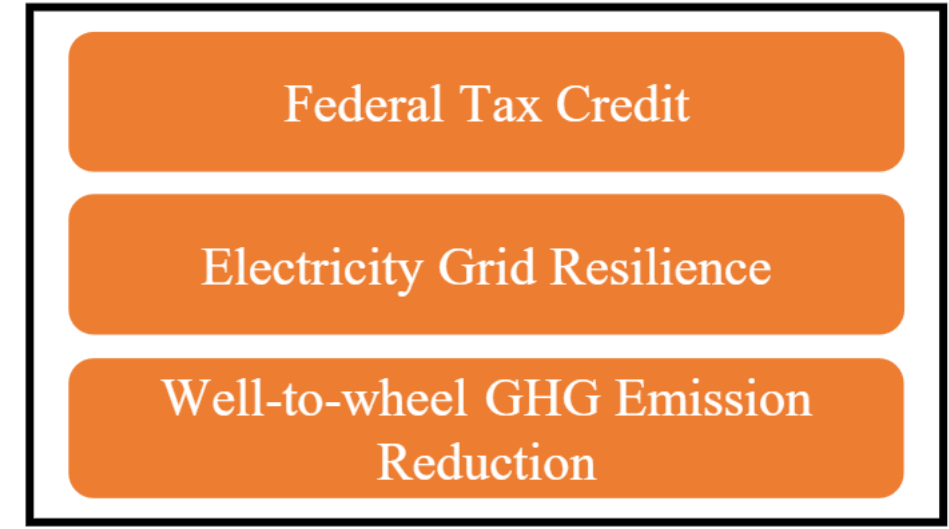
Figure 9. Socio-economic benefits of vehicle electrification.